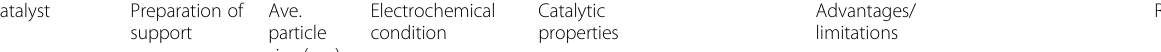
Table 2 summarize the preparation, physical properties, performance, and activity of Pt-based supported various carbon materials (Continued)